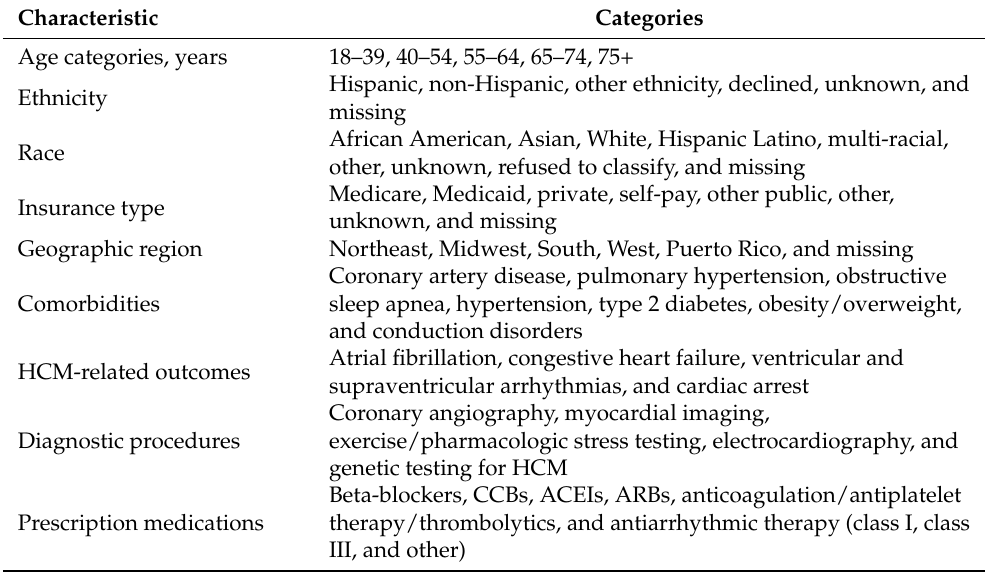
Table A1. Demographics and clinical characteristics assessment.